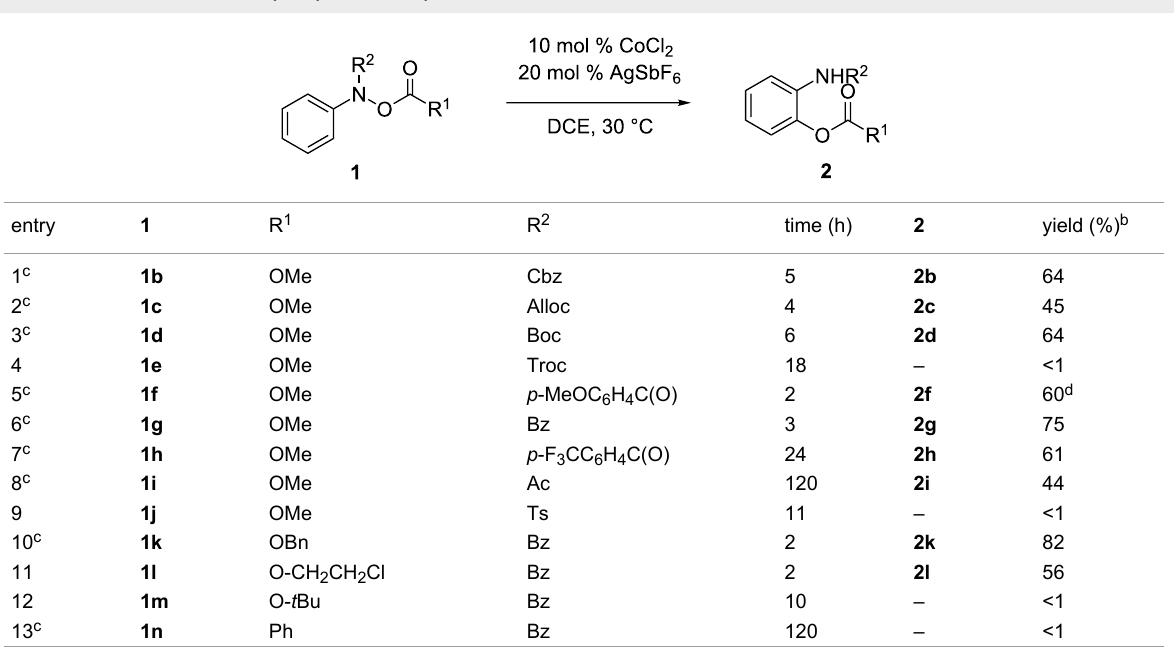
Table 3: Substituent effect at the hydroxylamine moiety. a